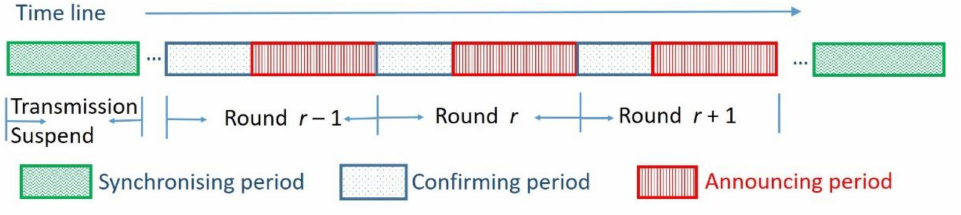
Figure 3. Three types of period in the